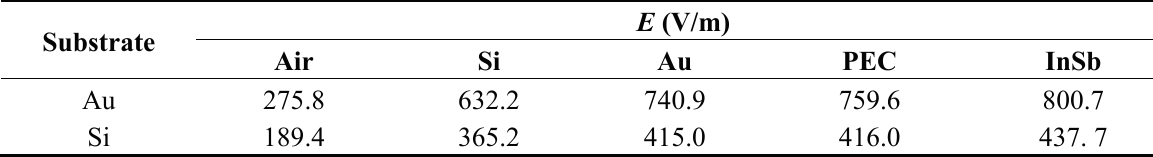
Figure 5. The electric field distribution of apex (Au)-Sample (hemisphere of InSb)-substrate (Au) system. Table 1 . Maximum electric field amplitude for different detected sample composed of different materials on the Au or Si substrate under the Au